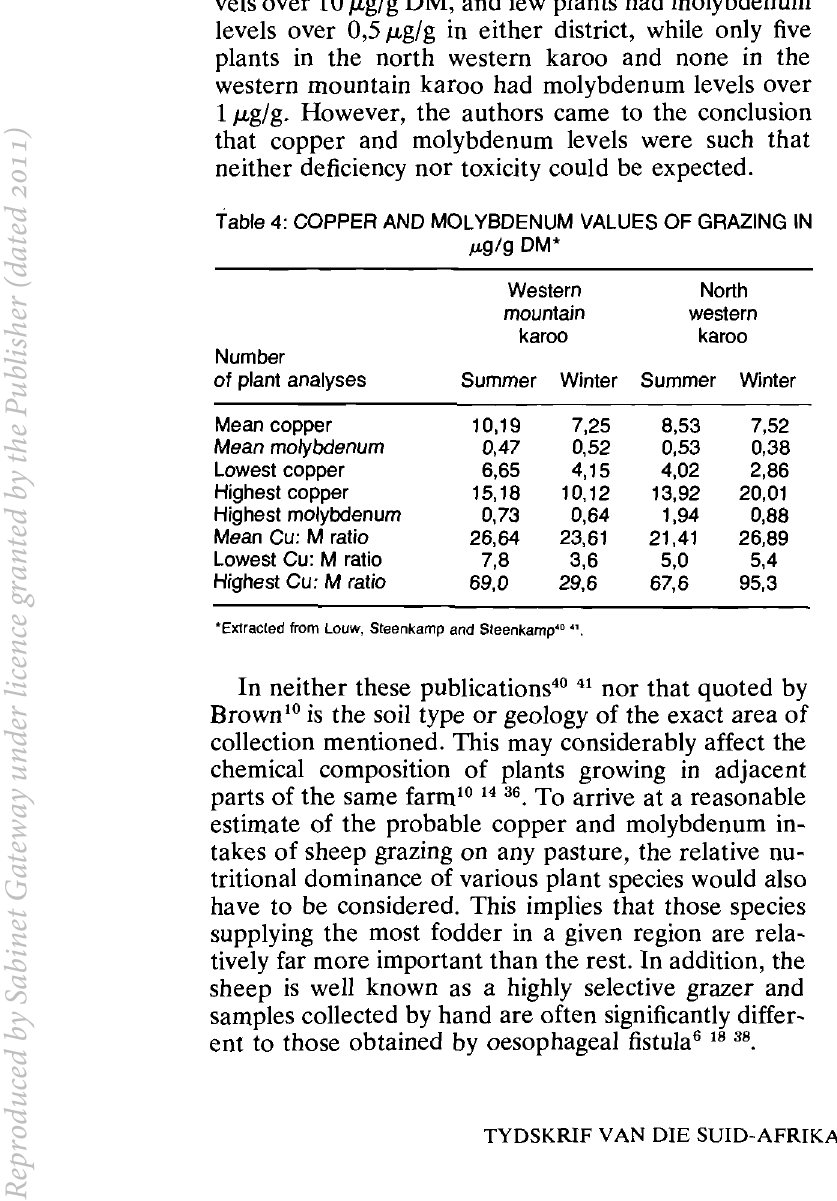
Table 4: COPPER AND MOLYBDENUM VALUES OF GRAZING IN J.Lg/g OM'